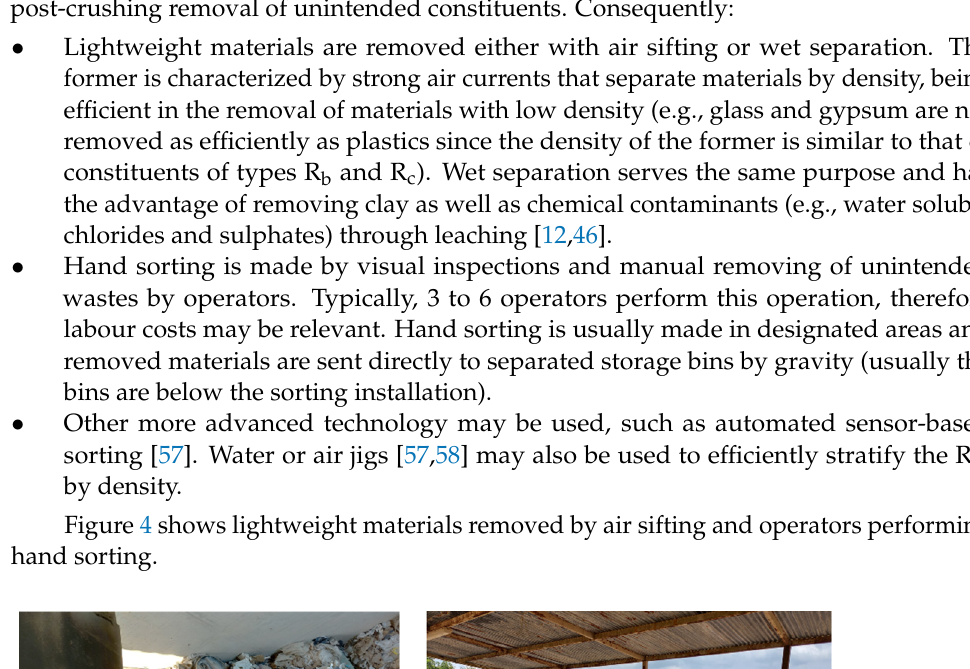
Figure 3. Crusher and magnetic separator( a ) Impact crusher ( b ) Magnetic separator discharging ferrous metals removed during RA production